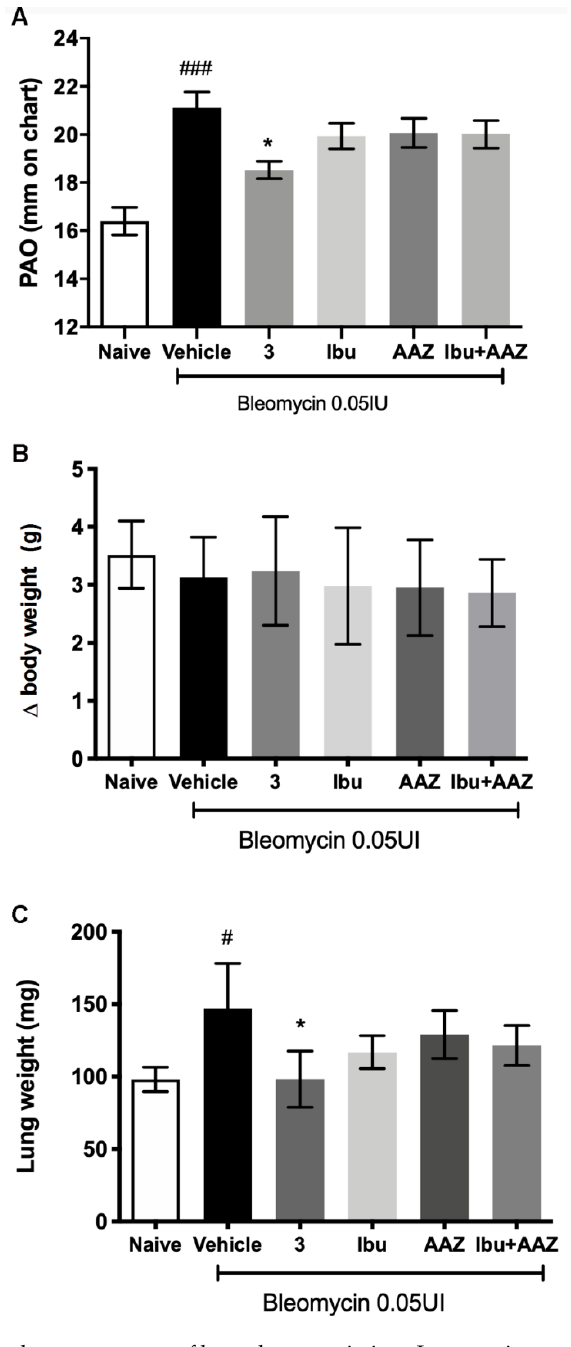
Figure 5. ( A ) Functional measurement of bronchoconstriction. Lung resistance to airflow measured through the evaluation of pressure at airway opening (PAO). Spirometric evaluation (mm on charts) of di ff erent treatments. ( B ) Variations of body weight after 3 weeks of treatments; ( C ) measurement of lung weight after bleomycin treatment in presence or absence of various treatments. Values represent the mean ± SEM of 6 individual mice from each group ( ### p < 0.001 vs. Naive; # p < 0.05 vs. Naive; * p < 0.05 vs. Naive; * p < 0.05 vs. Vehicle).